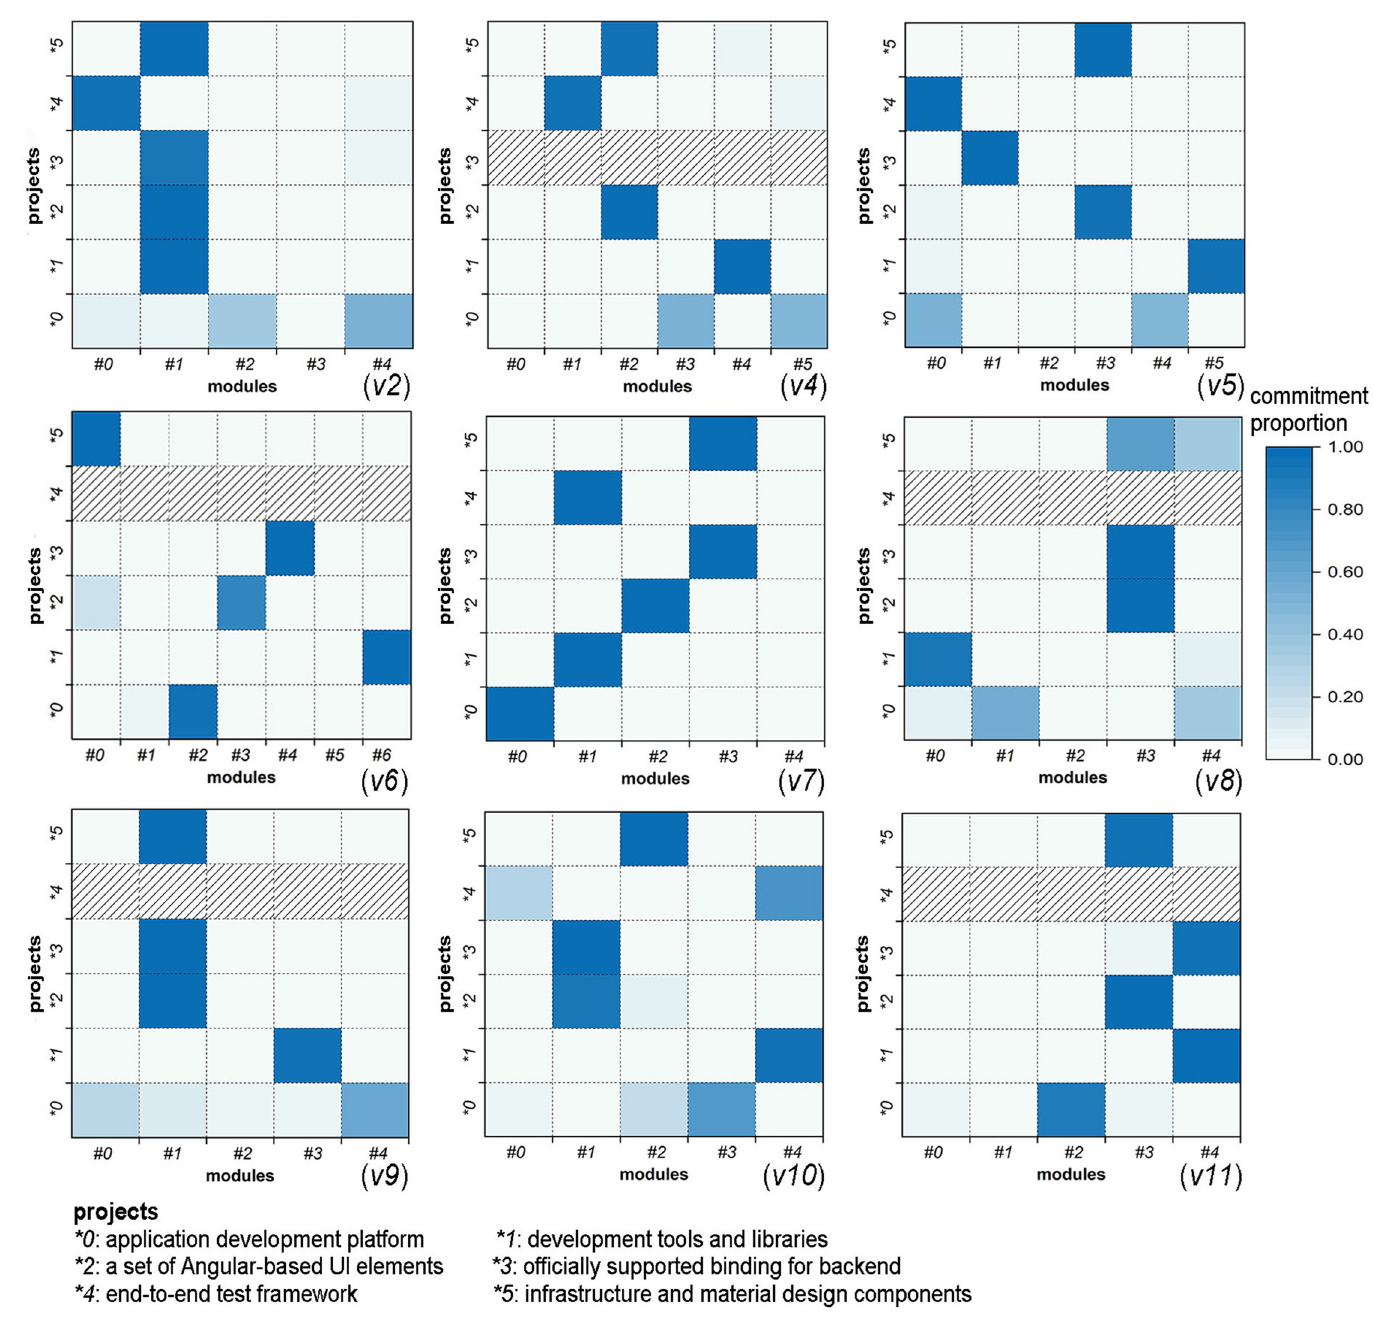
Fig 4. Relationship between modules and